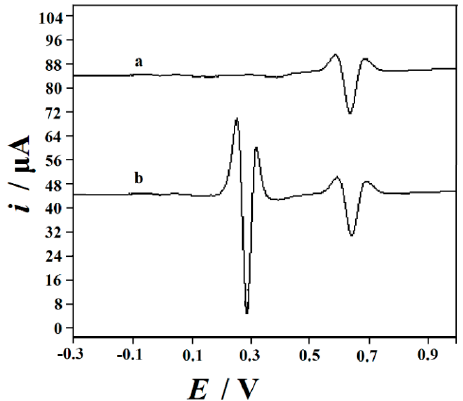
Figure 10. Second-order derivative linear scan voltammograms of 10 µ M rutin in the absence of ascorbic acid (AA) ( a ) and in the presence of 1.0 mM AA ( b ) on NH 2 -Fe 3 O 4 NPs-ErGO/GCE in 0.1 M HCl after a 120 s accumulation at − 0.3V. Scan rate is 0.1 V s − 1 .